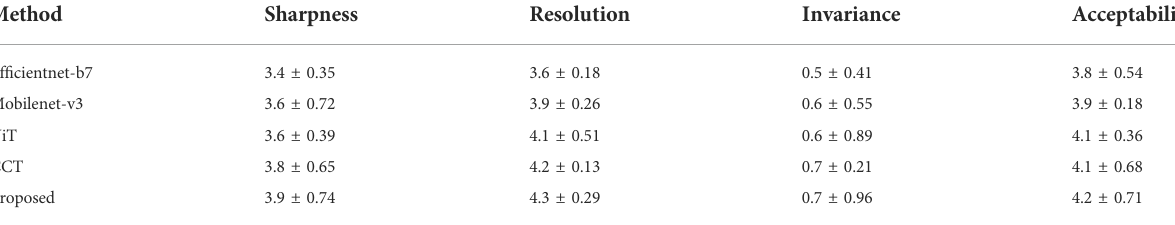
TABLE 6 Subjective quality evaluation of different